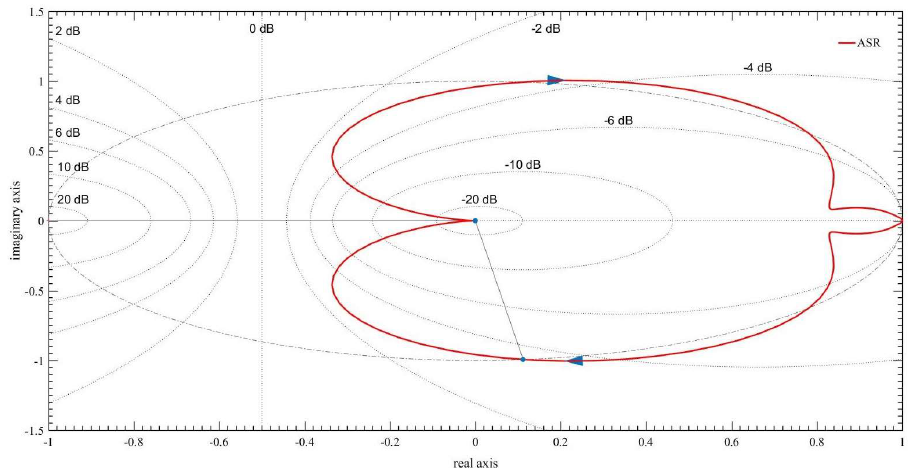
Figure 14. Nyquist diagram of double closed-loop control system.